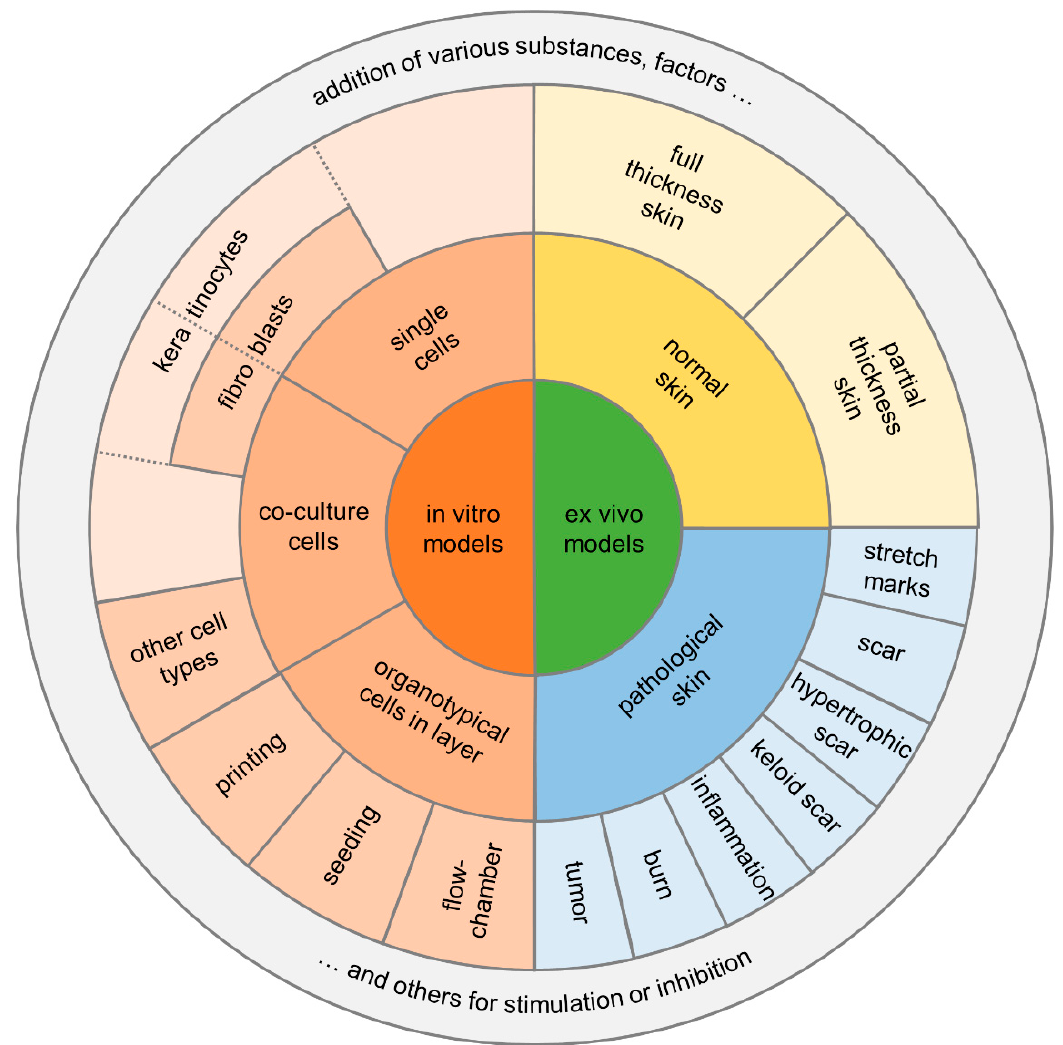
Figure 4. Diagram summarizing the two main categories for in vitro/ex vivo models and their potential assays.